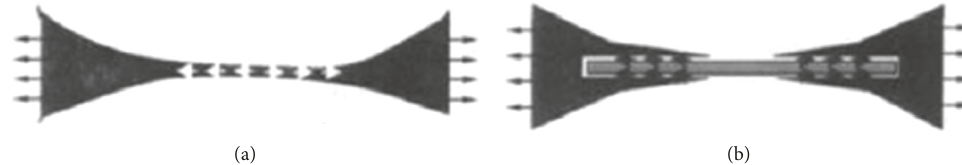
Figure 13: Failure mechanism of asphalt concrete: without steel fiber (a) and with steel fiber